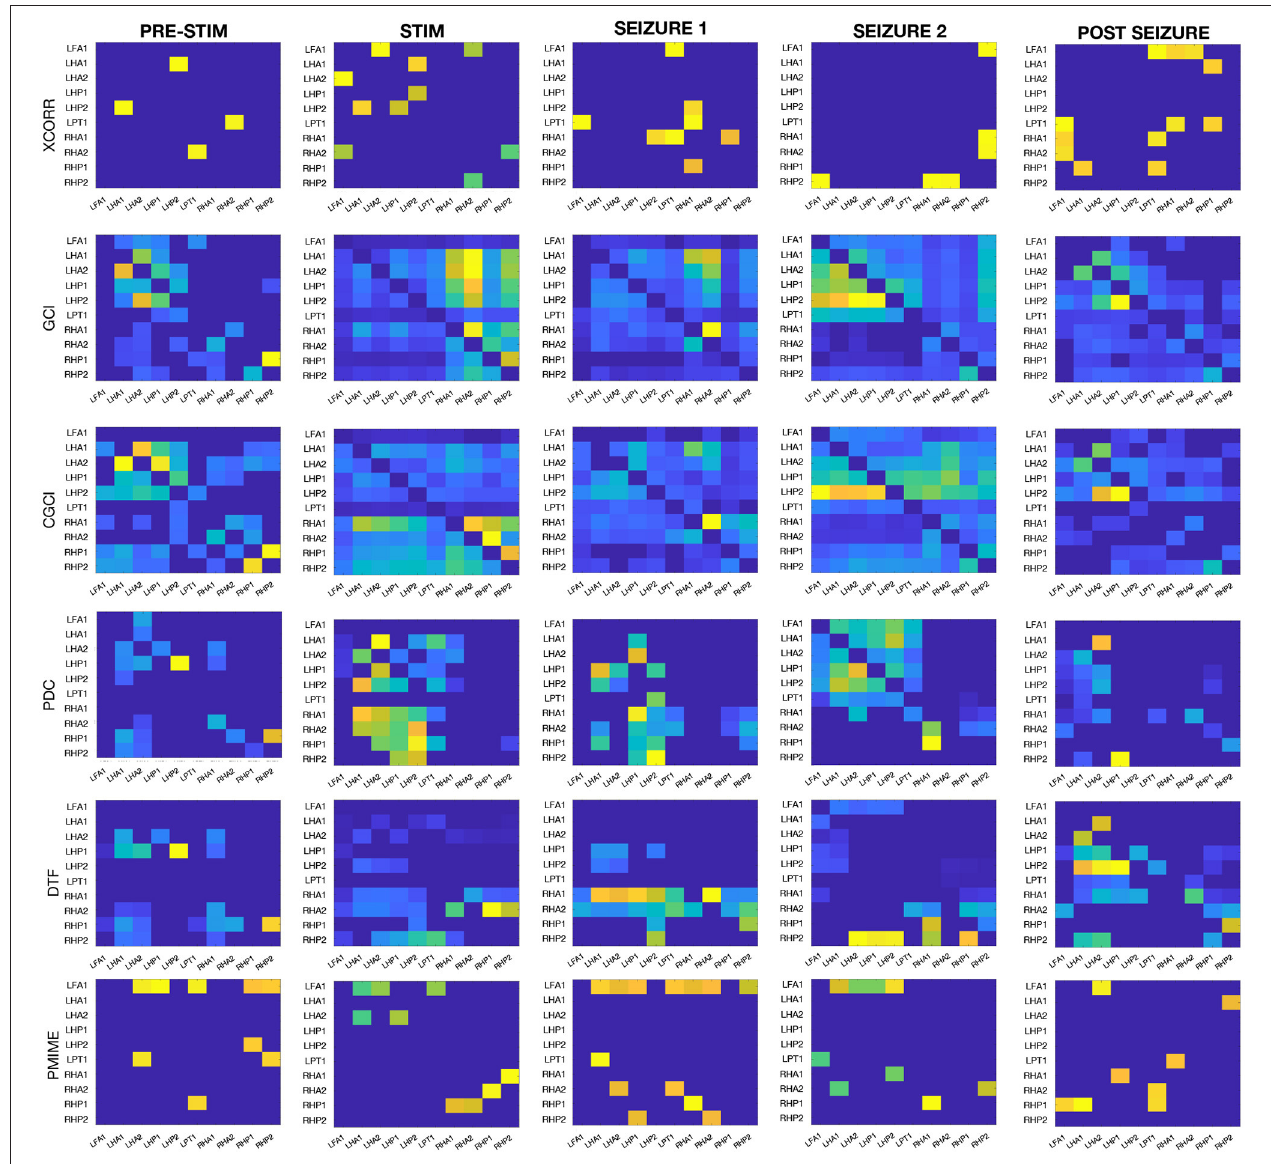
FIGURE 7 | Connectivity results from the sEEG data. Each row contains the connectivity matrices from one of the causality metrics when applied on each of the epochs before/during stimulation, at the beginning/end of the seizure, and after the